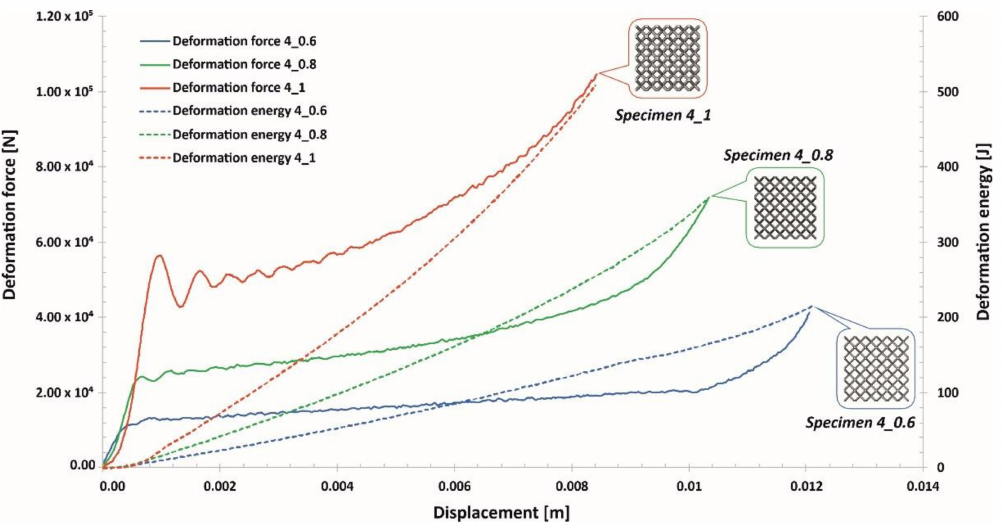
Figure 20. Deformation force and energy plots determined for lattice structures with an elementary unit cell equal to 4 mm under dynamic tests.